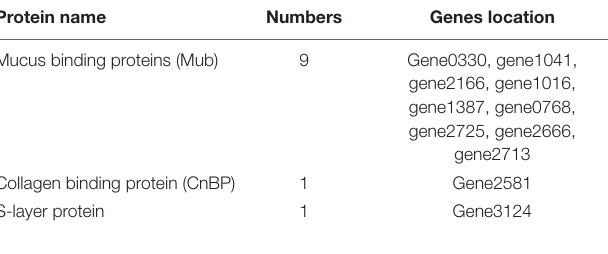
TABLE 1 | Adhesion-associated proteins in W2